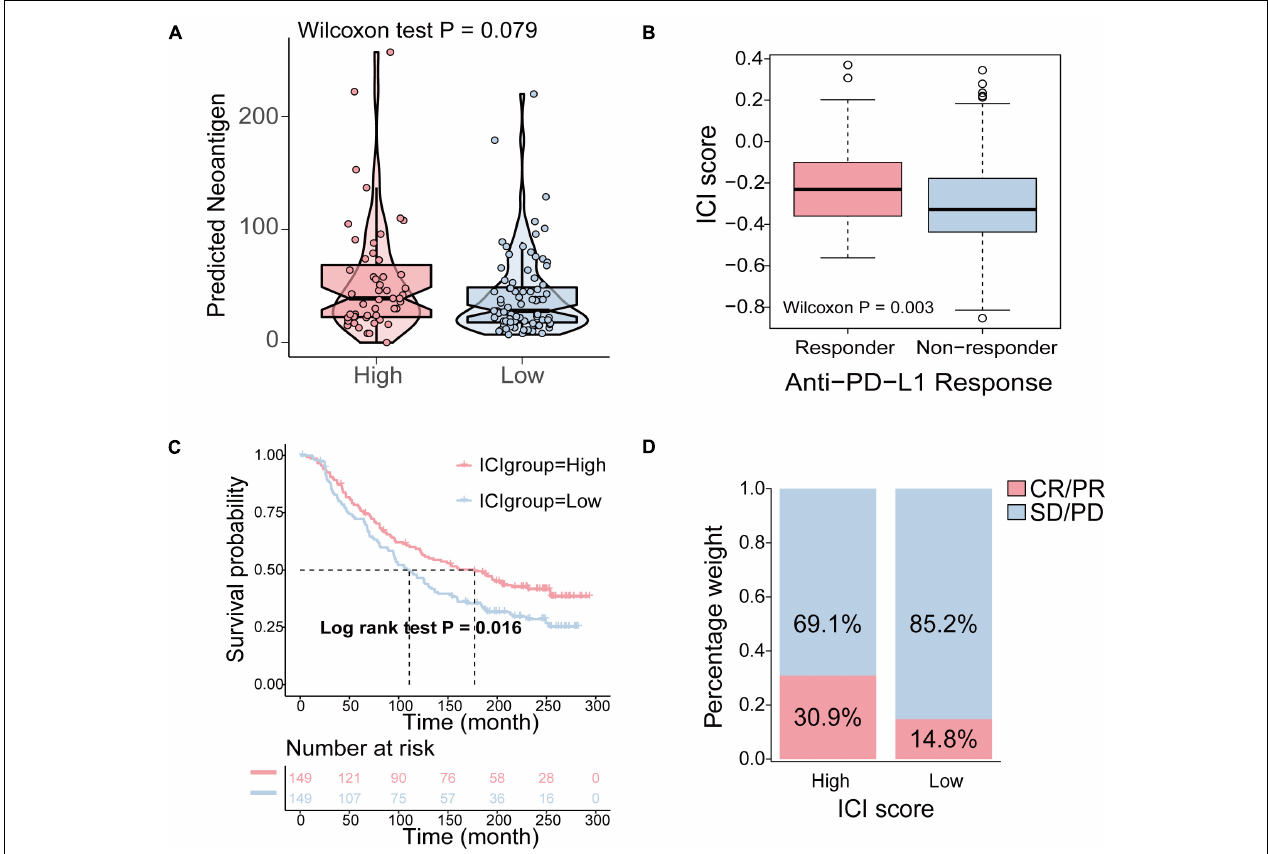
FIGURE 7 | The relationship between the ICI score and antitumor immunity and the role of ICI pattern in anti-PD-L1 immunotherapy. (A) The difference of the number of neoantigens in the high and low ICI score groups (Wilcoxon test, p = 0.079). (B) The comparison of the ICI score in different anti-PD-1 clinical response statuses (Wilcoxon test, p = 0.003). (C) Kaplan–Meier curves for patients in the high and low ICI score group in the IMvigor210 cohort (log-rank test, p = 0.016). (D) The rate of clinical response to anti-PD-L1 immunotherapy in the high and low ICI score groups in the IMvigor210 cohort (CR, complete response; PR,